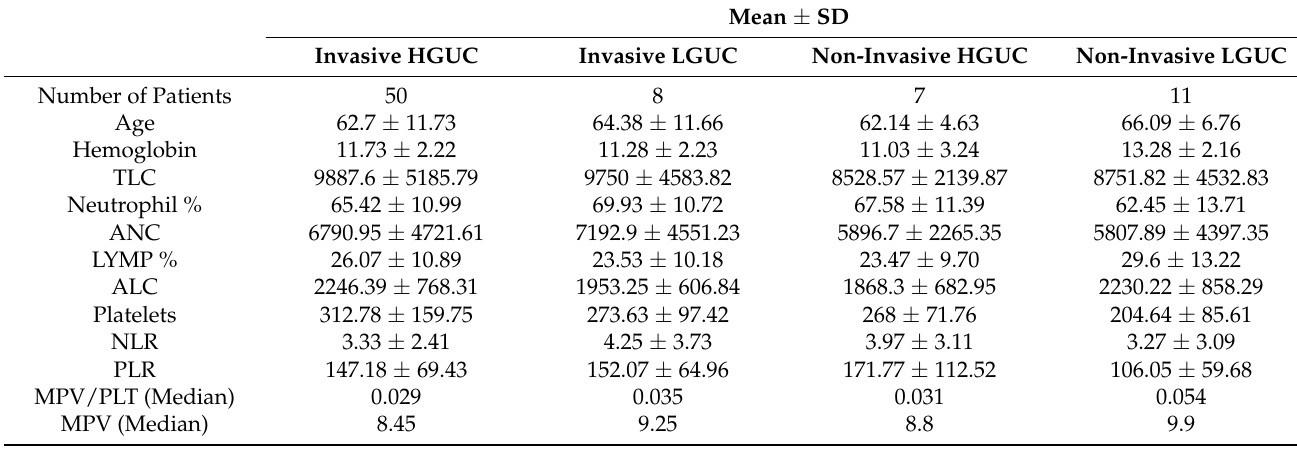
Table 1. Demographic data.